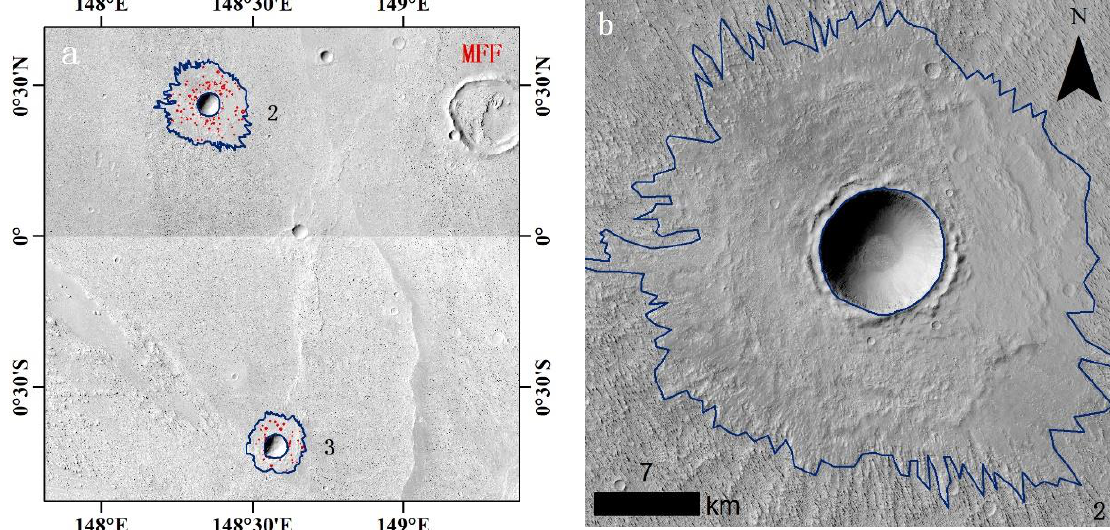
Figure 1. The spatial relationship between yardangs and layered ejecta craters. ( a ) Two layered ejecta craters in the Medusae Fossae Formation (MFF); ( b ) one typical layered ejecta crater superposed on yardangs. The background is a Context Camera (CTX) mosaic (5 m/pixel).